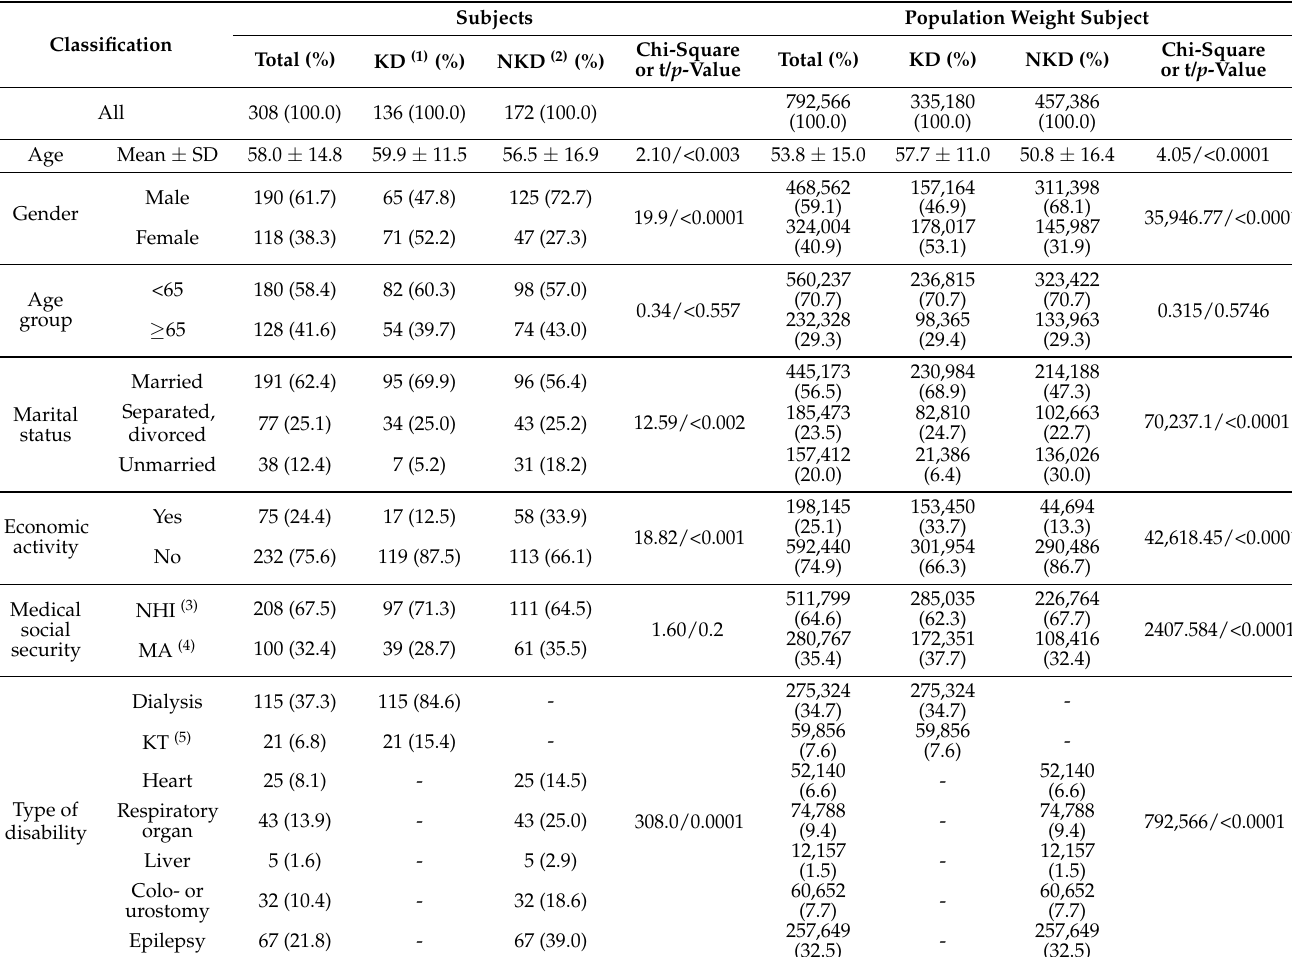
Table 1. Socio-demographic characteristics of the kidney and non-kidney disabled in five-year Korea Health Panel (KHP) pooled